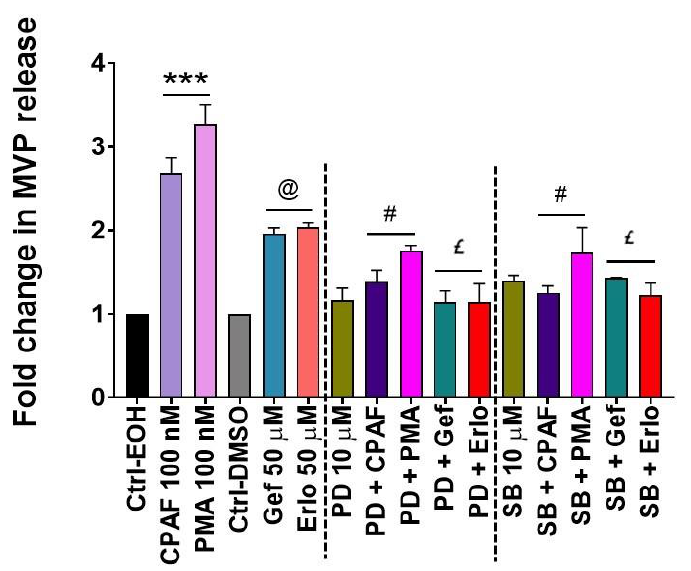
Figure 6. Effects of the extracellular signal-regulated kinase (ERK1/2) and p38-MAPK inhibitors on gefitinib and erlotinib-induced MVP release. A549 cells were pretreated with PD98059 and SB202190 (10 µM, 1 h) followed by the treatments with 0.1% EOH or DMSO as negative controls, 100 nM CPAF or PMA as positive controls, and 50 µM Gef or Erlo. After 4 h of incubation, we isolated and analyzed MVP secretion. Data are mean ± SE from three independent experiments, normalized per 1 × 10 6 cells, and represented as Fold change in MVP release over various treatment groups. Statistically significant differences were observed between Ctrl-EOH and CPAF or PMA (*** = p < 0.001); Ctrl-DMSO and Gef or Erlo (@ = p < 0.01); CPAF vs. PD + CPAF or SB + CPAF (# = p < 0.001); PMA vs. PD + PMA or SB + PMA (# = p < 0.001); Gef vs. PD + Gef or SB + Gef, and Erlo vs. PD + Erlo or SB + Erlo (£ = p < 0.05).